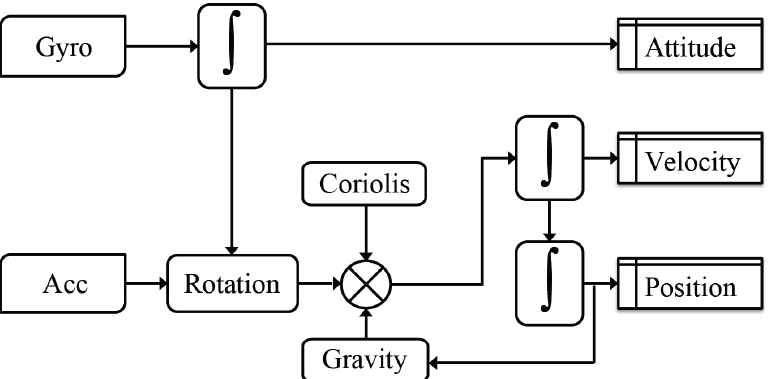
Figure 1. Simplified flowchart of strapdown mechanization equations.